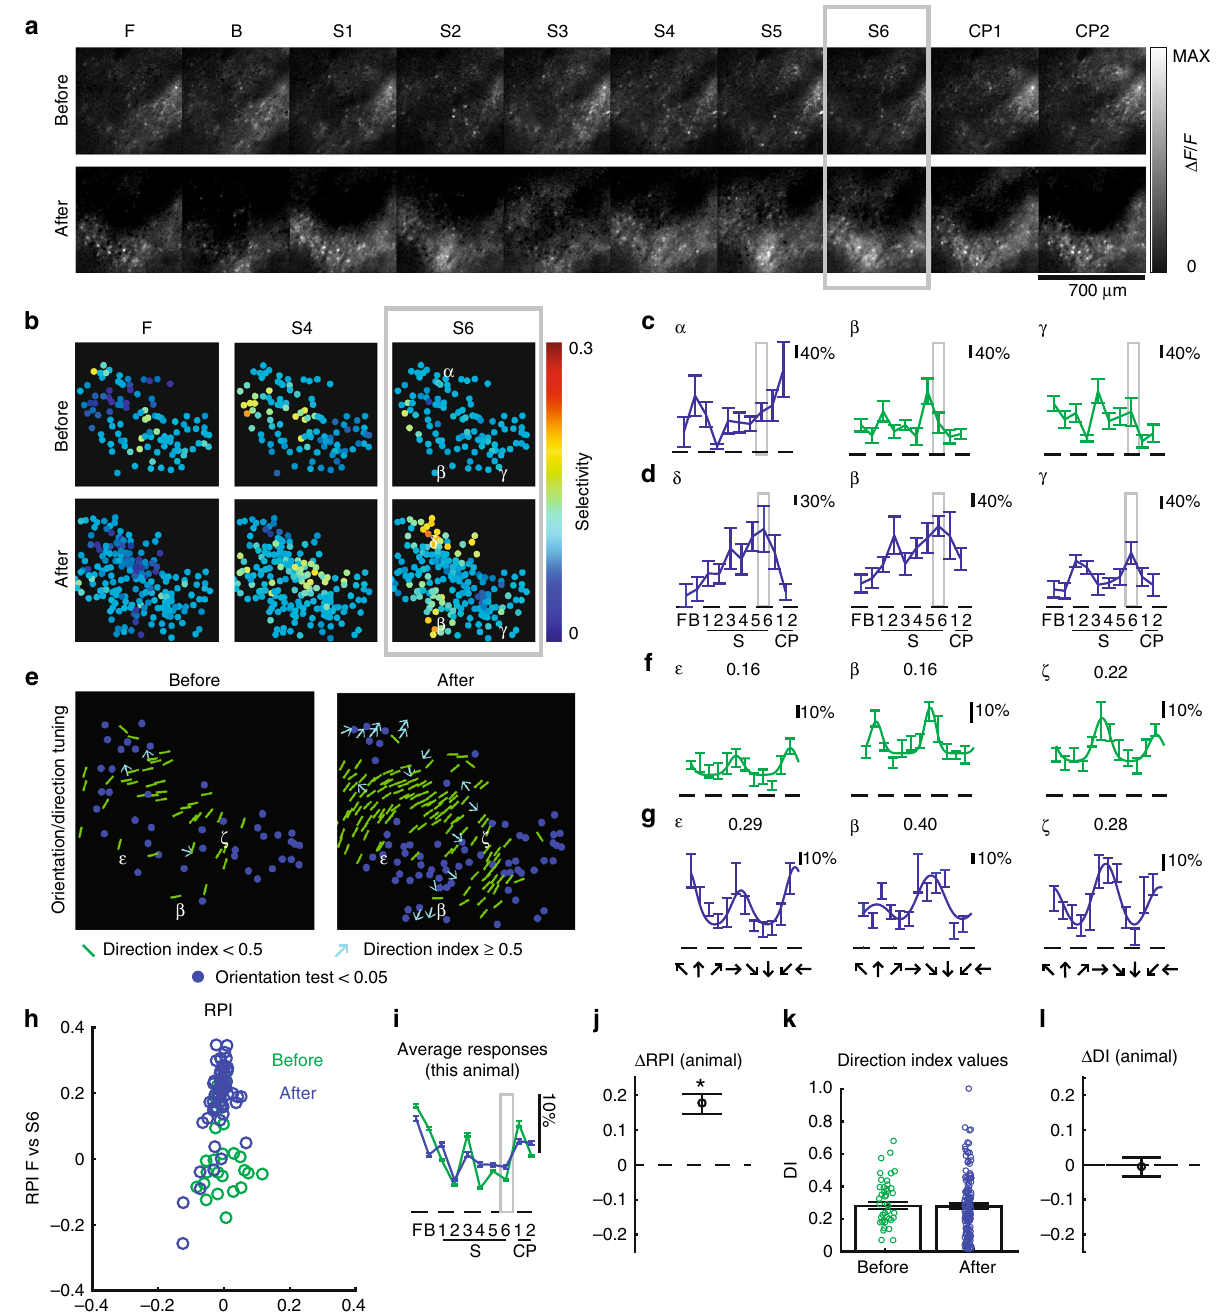
Fig. 3 In a second visually naive ferret, 6 h of experience with a phase-scrambled grating pattern caused an increase in selectivity for that pattern. The eyes were opened prematurely on P31. Panels a – l are as described in Fig. 2, except that S6 was used as the training stimulus. In this animal, some cells were tracked across time and Greek letters appear more than once. This animal exhibited increased selectivity to training stimulus S6, and no signi fi cant alterations to direction selectivity. N = 25 cells before and N = 62 cells after for measurements of F, B, S1 – 6, CP1 – 2, and N = 41 cells before and N = 145 cells after for direction tuning. Premature animals varied in the in fl uence of phase-scrambled grating patterns on traditional direction